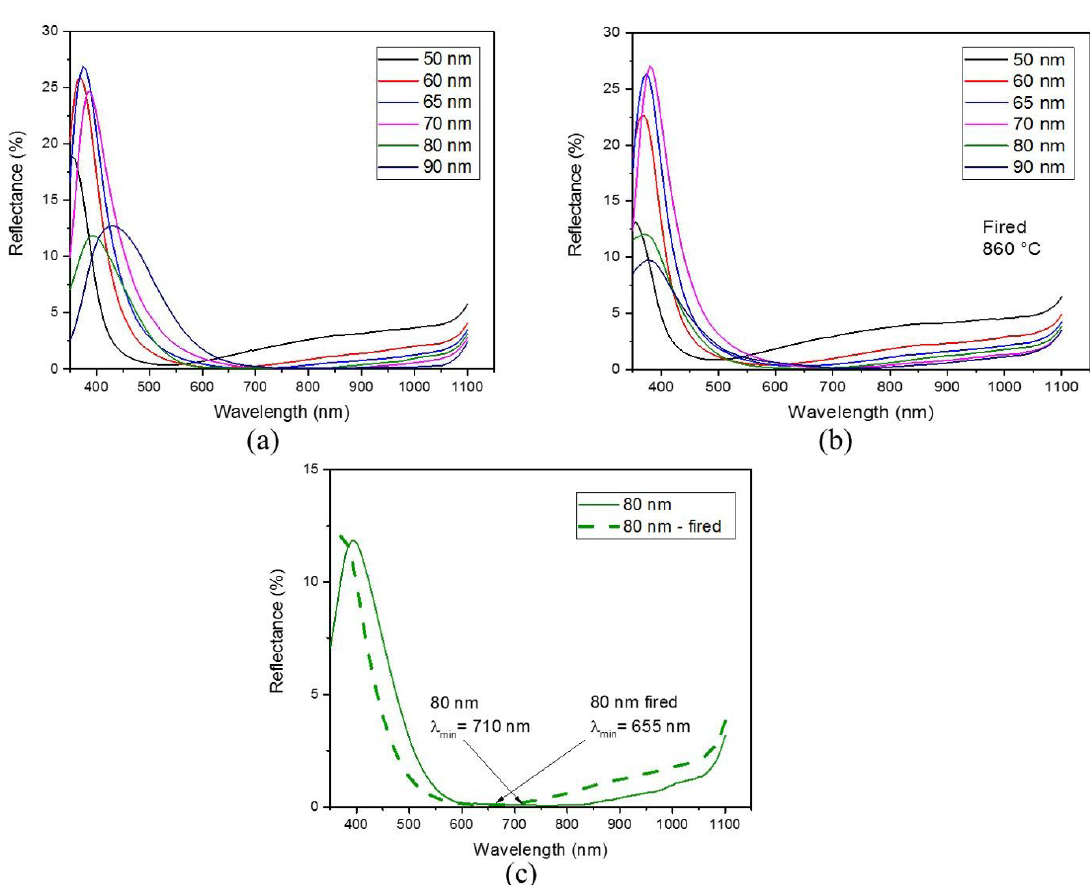
coated textured silicon wafers (a) before, (b) after a thermal process at 860 °C (metal paste firing) and (c) Figure 4. Reflectance of TiO 2 for 80 nm thick films (before and after firing).